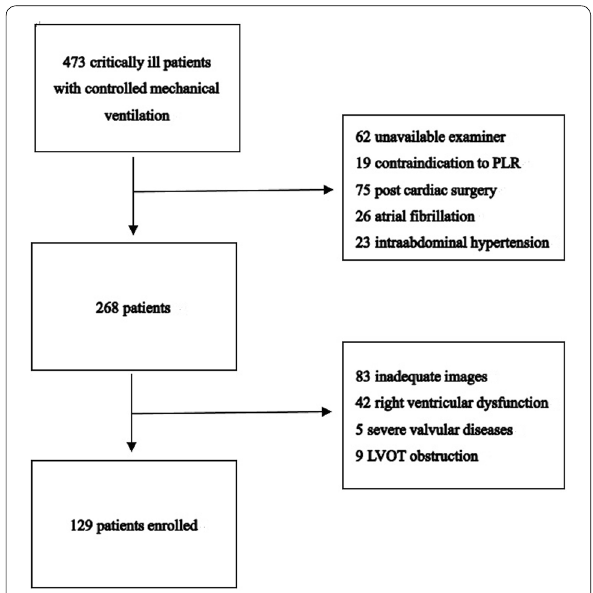
Fig. 1 Flow chart of the study. PLR passive leg raising, LVOT left ventricular outflow